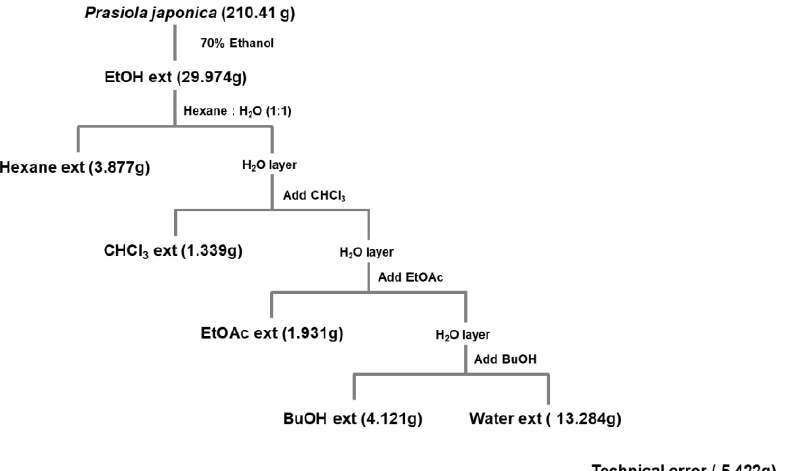
Figure 6. Schematic: preparation of ethanolic extract and four solvent fractions of Prasiola japonica .